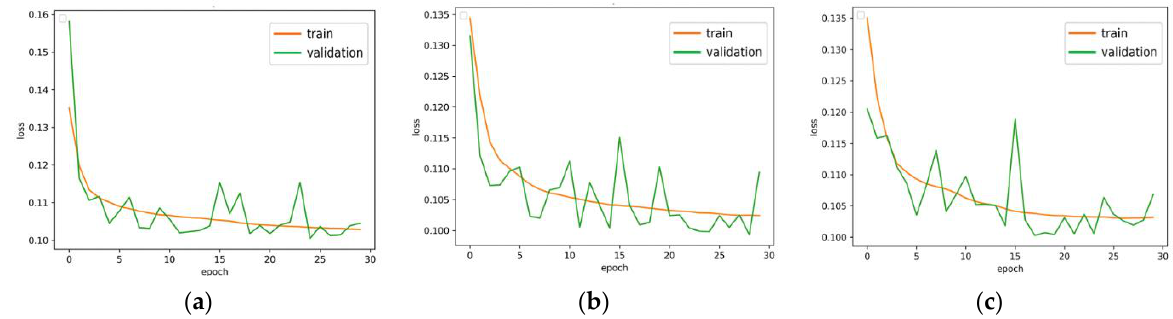
Figure 9. Learning curves of loss reduction of model with ( a ) two hidden layers, ( b ) three hidden layers, and ( c ) four hidden layers during the training phase.